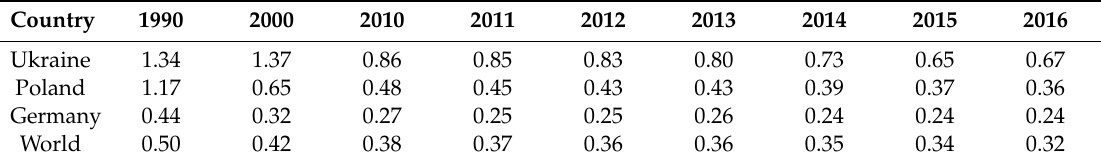
Table 4. CO2 emission intensity at constant parity of purchasing power, kg C О 2 / $ 2005.